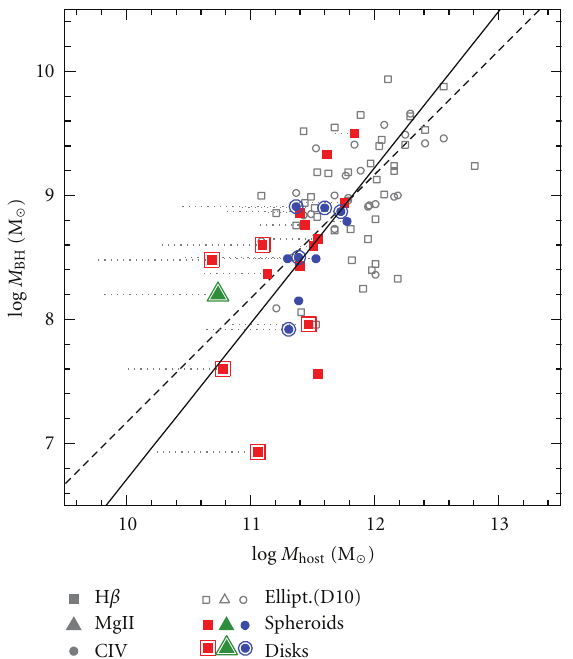
Figure 4: The M BH - M host relation in the objects in our sample (filled symbols), as compared with the z < 0 . 5 sample from [58] (empty symbols) and the local relation ( M BH /M host = 0 . 0015; see [9]). Squares, triangles, and circles refer to M BH estimates derived from H β , Mg II , and C IV respectively. Our new data substantially extend the sampled range of the M BH - M host relation. The relation holds down to quasar host masses of ∼ 10 11 M (cid:3) (BH masses of ∼ 10 8 M (cid:3) ). There is no evidence of a population of objects lying below the relation, as claimed by [62]. The overall scatter of the M M BH - host relation is 0.44 dex, and it extends over 2 dex both in terms of host galaxy and BH mass. Dotted, horizontal lines show how our objects would move if the correction for the bulge-to-total luminosity ratio is taken into account (see the text for details). The solid line is the best fit to our data.